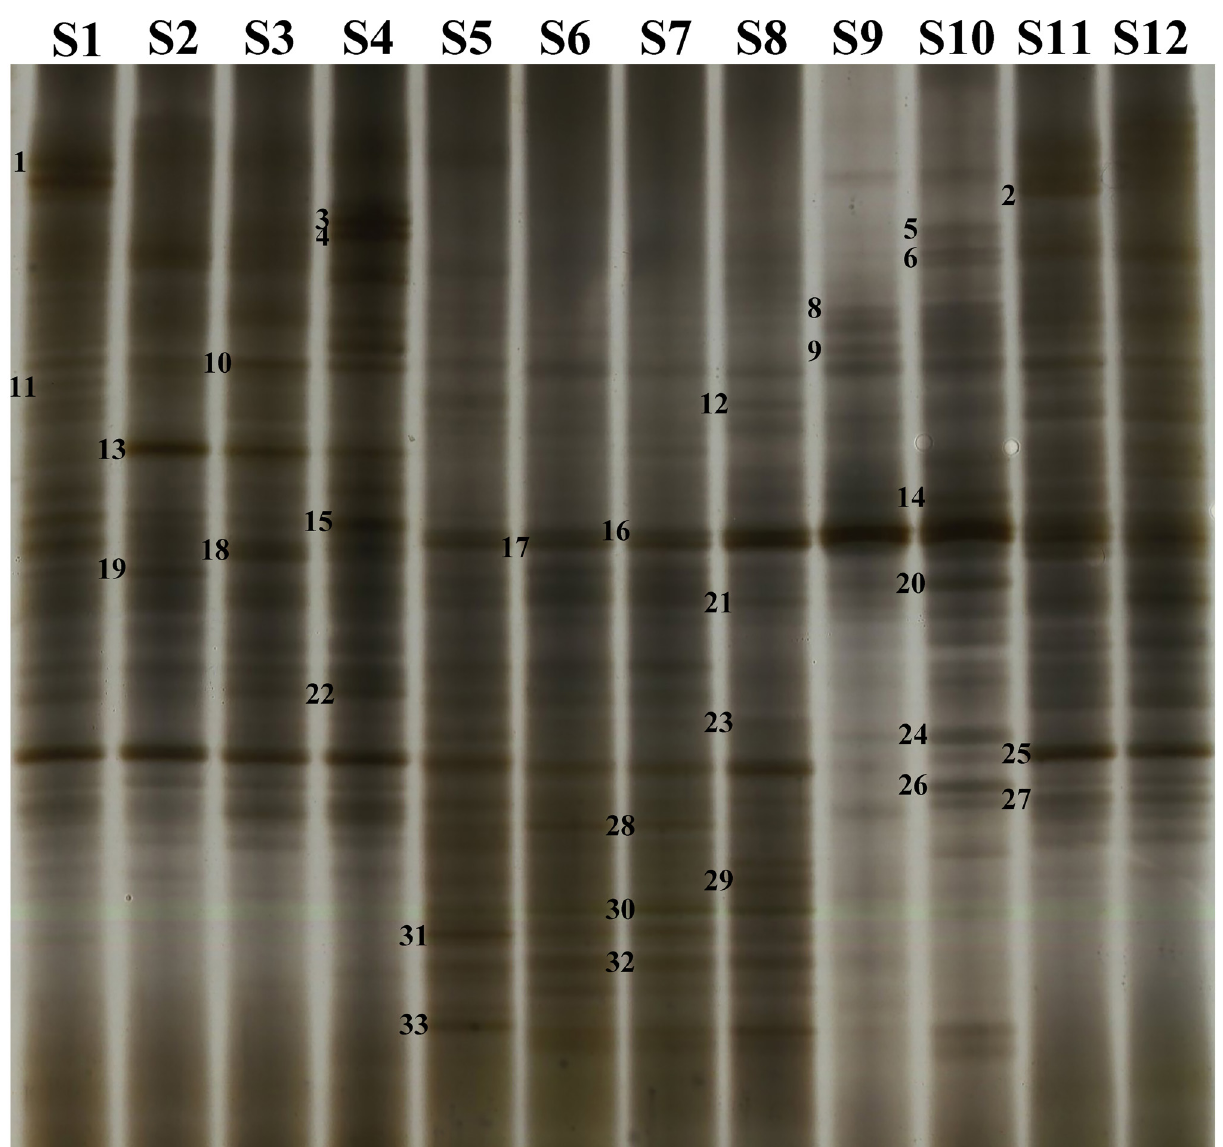
Fig 2. DGGE analysis of 16S rDNA fragments obtained after PCR amplification of the variable V3 region with universal primers 338F and 534R. The DGGE profiles for the total microbial DNAs extracted from samples are shown. The samples are described in Table 2. The numbers in the figures indicate the DGGE bands selected for cloning and